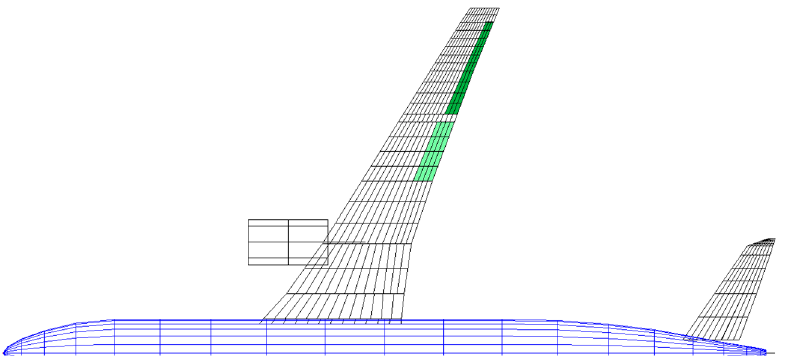
Figure 18. Deflected control surfaces using the reference MLA algorithm.